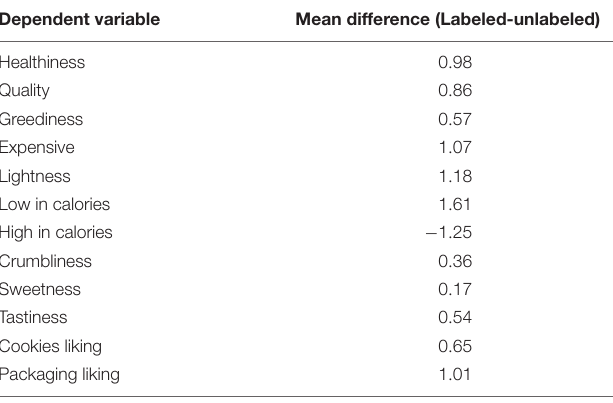
TABLE 5 | Mean differences for presence vs. absence of label and regardless of type (jar vs. bag) and level of transparency (transparent vs. opaque) of the packaging.